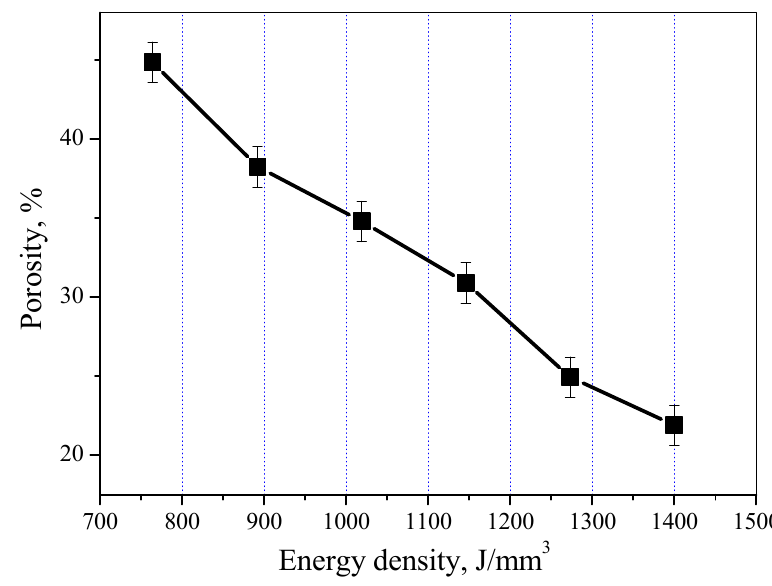
Figure 4. Porosity variation curve of the LAMed ZK61 deposited at different E .